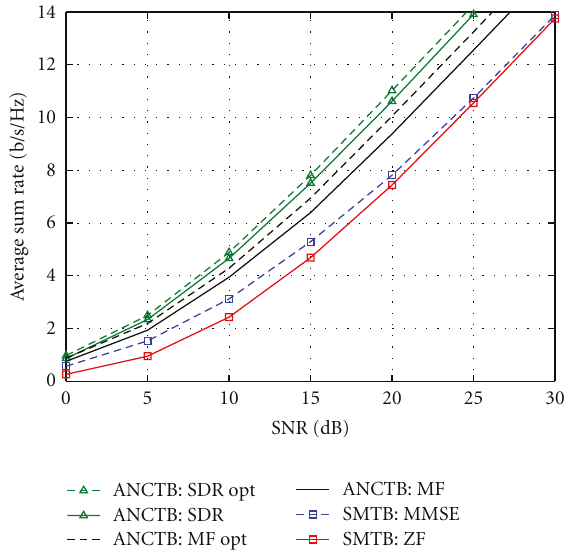
Figure 5: Sum rate performance of three-way relaying with asymmetric tra ffi c: SMTB versus